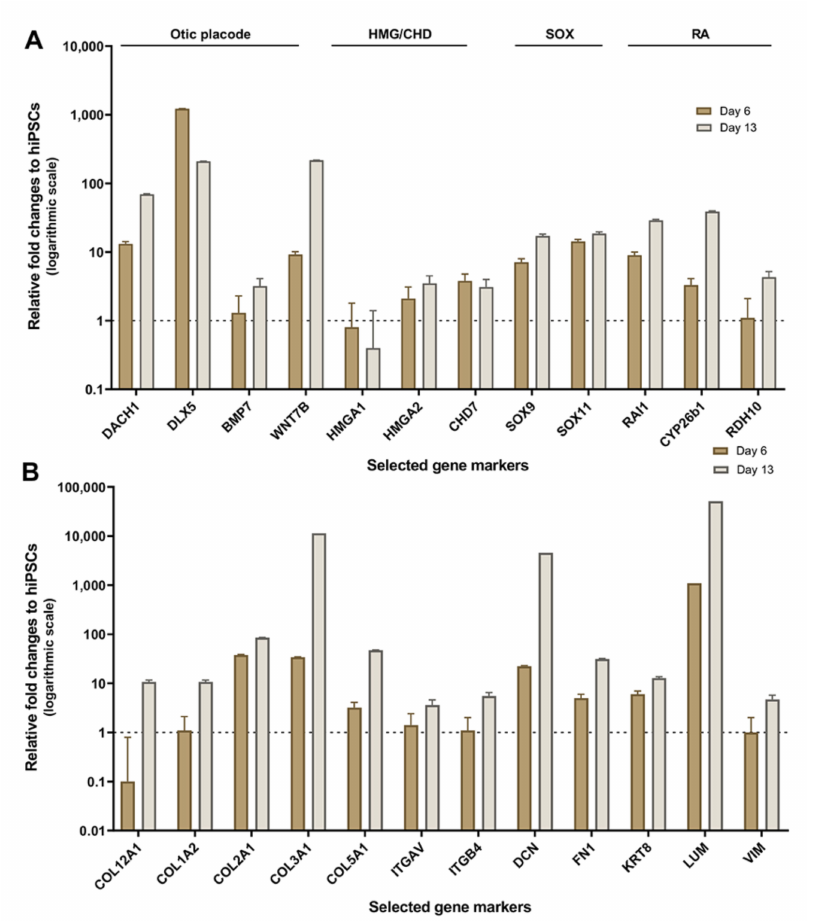
Figure 6. Validation of HTS results by real-time qRT-PCR. ( A ) qPCR expression profiles in day 6 to day 13 culture samples relative to undifferentiated hiPSCs (day 0) were plotted as fold change. Bar charts represent the relative gene expression levels obtained for distinct panels of markers featuring members of otic/placodal, HMG/CHD7, SOX and RA gene families, respectively. Noticeably, results confirm the upregulation of otic/placodal ( DACH1 , BMP7 , etc.) HMG ( HMGA1, HMGA2, etc.) CHD7, SOX ( SOX9 , SOX11 , etc.) and RA ( RAI1 , RDH10 , etc.) genes in differentiated cells at day 6 and day 13 in vitro, which is the condition that yielded optimal otic sensory induction. ( B ) qPCR expression profiles in day 6 to day 13 culture samples showing a panel of upregulated ECM ( COL1A 2, COL2A1 , COL3A 1, etc.) and ITG ( ITGAV , IGTB4 ) genes during the time course of hiPSCs differentiation in vitro confirming HTS results. Relative gene expressions were calculated according to the 2 − ( ∆∆ Ct) method normalized with each gene expression at day 0 in vitro. Data are represented in logarithmic scale with the error bars represent SD of five technical